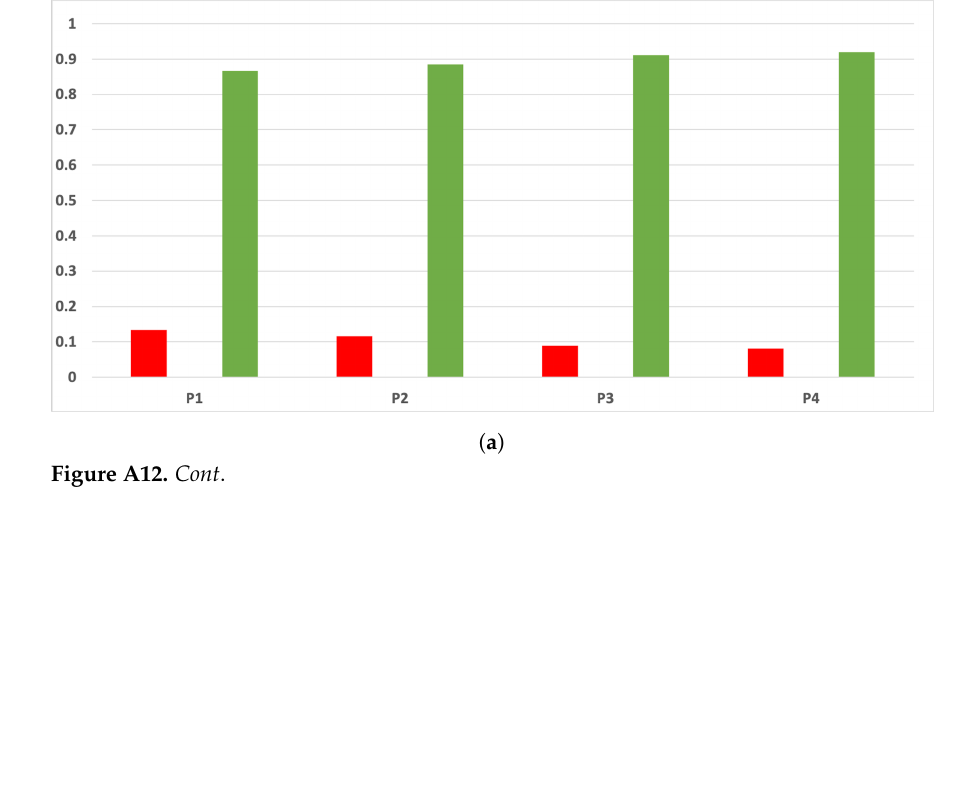
Figure A11. Experiment 1: consistency per dataset. Rate of validity with the accuracy and time com- plexity. ( a ) Rate of validity per dataset in DT. ( b ) Rate of validity per dataset in KNN.